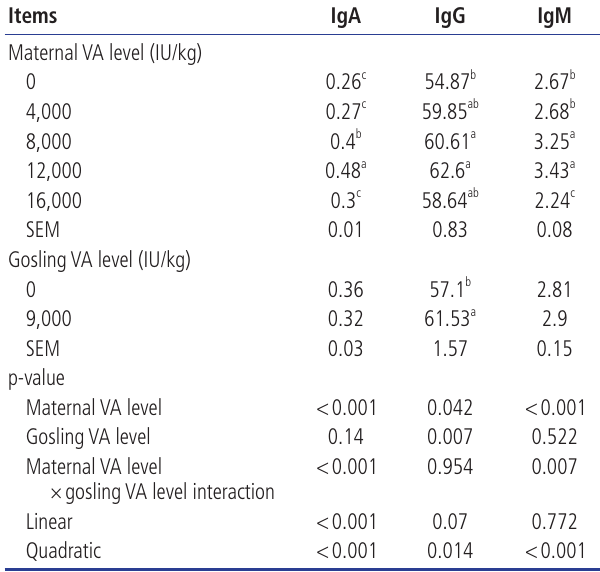
Table 5. Effects of different vitamin A levels of maternal and offspring diets on immune organ index of offspring Items